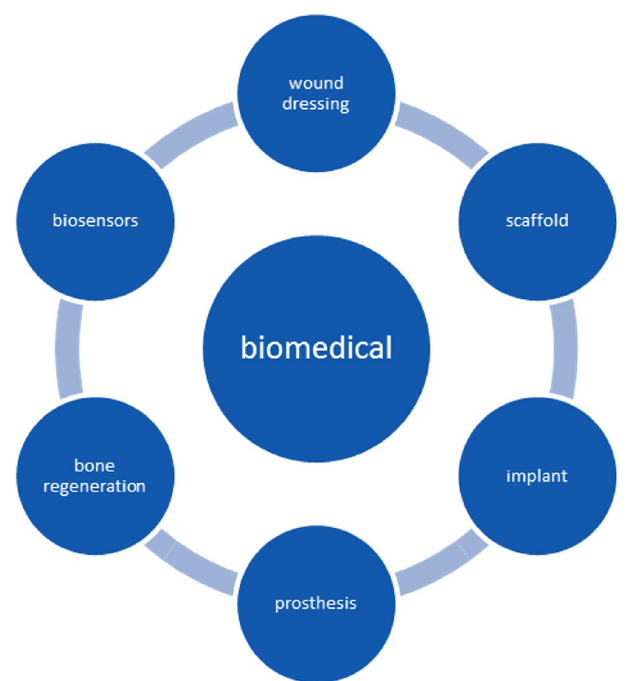
Fig. 3. Bio medical applications of bacterial